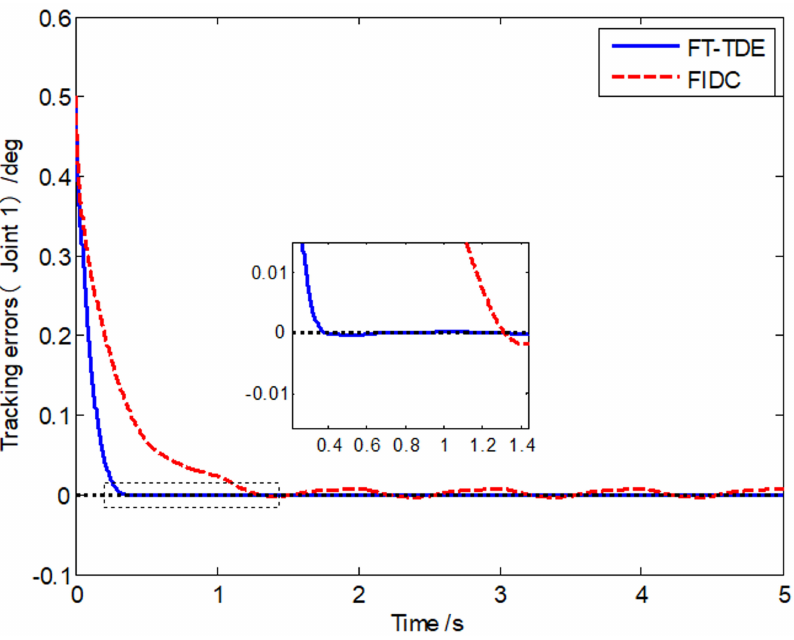
Figure 1. Tracking errors of Joint 1.